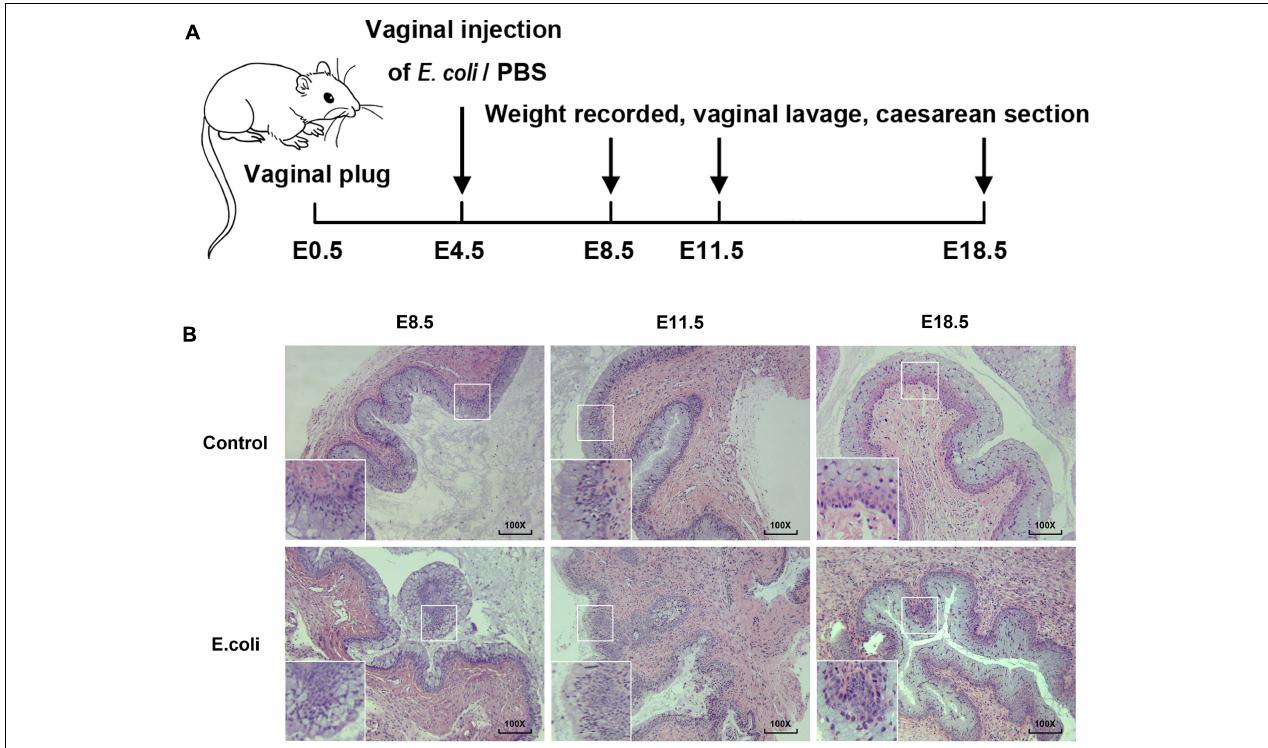
FIGURE 1 | Construction of animal models of vaginal infection induced by E. coli . (A) The flow of animal experiments in this study. (B) H&E staining of vaginal tissue in the study group and the control group of mice at E8.5, E11.5, and E18.5. The magnification of the microscope examination used was 100 ×